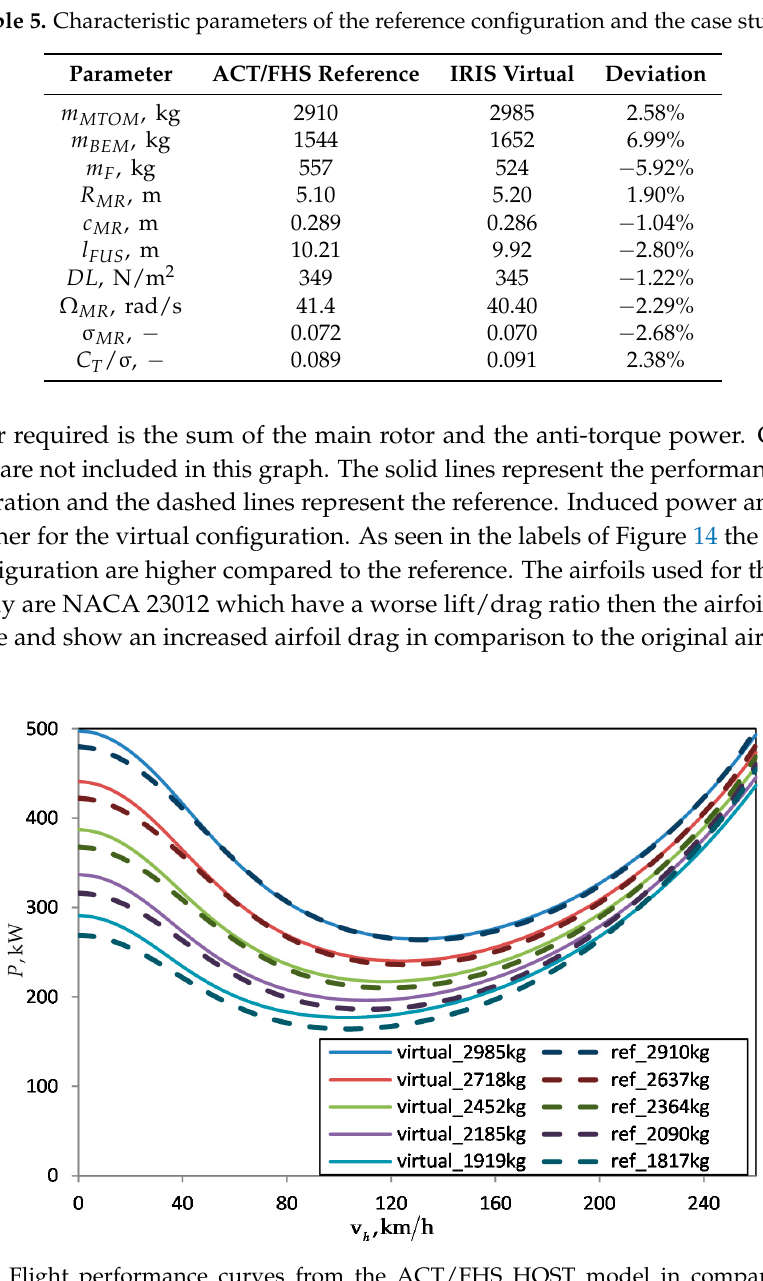
Figure 14. Flight performance curves from the ACT/FHS HOST model in comparison to the design output.